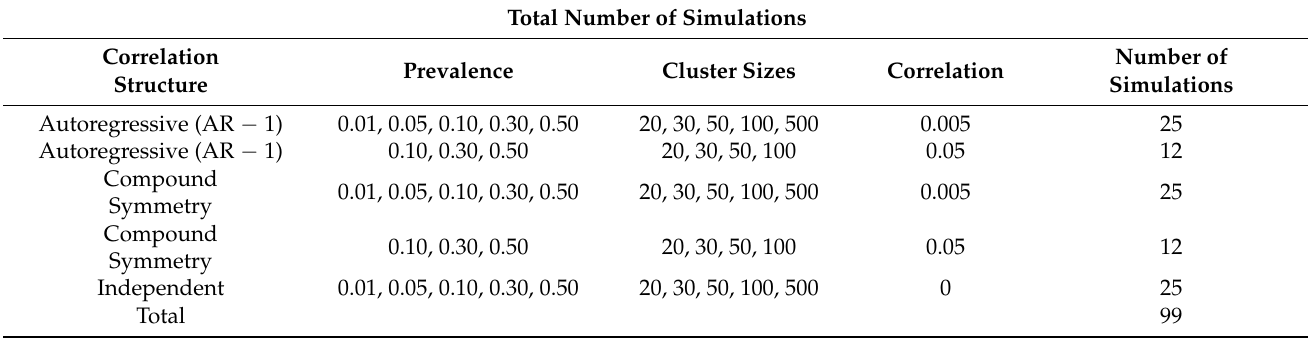
Table 2. Prior simulation designs for comparing the performance of the six estimators listed in Table 1.